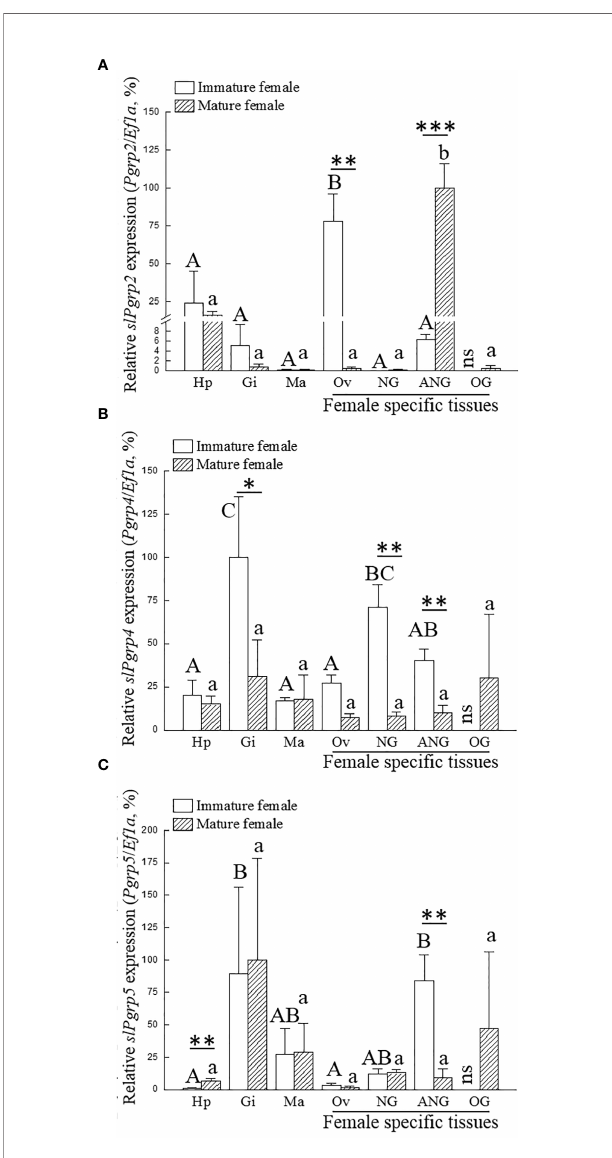
FIGURE 3 | Expression of slPgrp transcripts in various tissues. The gonadal stage of female squid was distinguished by histology. Immature (n = 3; primary oocyte stage) and mature (n = 3; vitellogenic oocyte stage) females were used to analyze gene expression in different tissues. Three slPgrp genes were selected for analysis, including slPgrp2 (A) , slPgrp4 (B) , and slPgrp5 (C) . Different capital letters indicate signi fi cant differences between tissues in immature female ( P < 0.05). Different lower-case letters indicate signi fi cant differences between tissues in mature female ( P < 0.05). Asterisks indicate signi fi cant difference between the immature and mature females (* P < 0.05, **P < 0.01, and ***P < 0.001, respectively). Hp, hepatopancreas, Gi, gill; Ma, mantle (muscle); Ov, ovary; NG, nidamental gland; ANG, accessory nidamental gland; OG, oviductal gland; ns, no